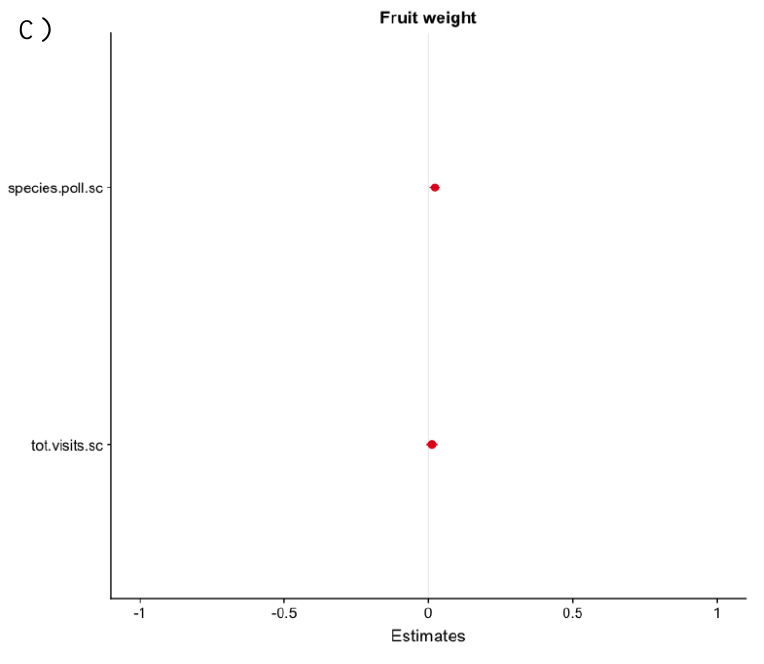
Figure S5 . Forest plots showing 95% confidence intervals for all coefficients included in site-level models, A) fruit set, B) number of seeds per fruit and C) fruit and seed